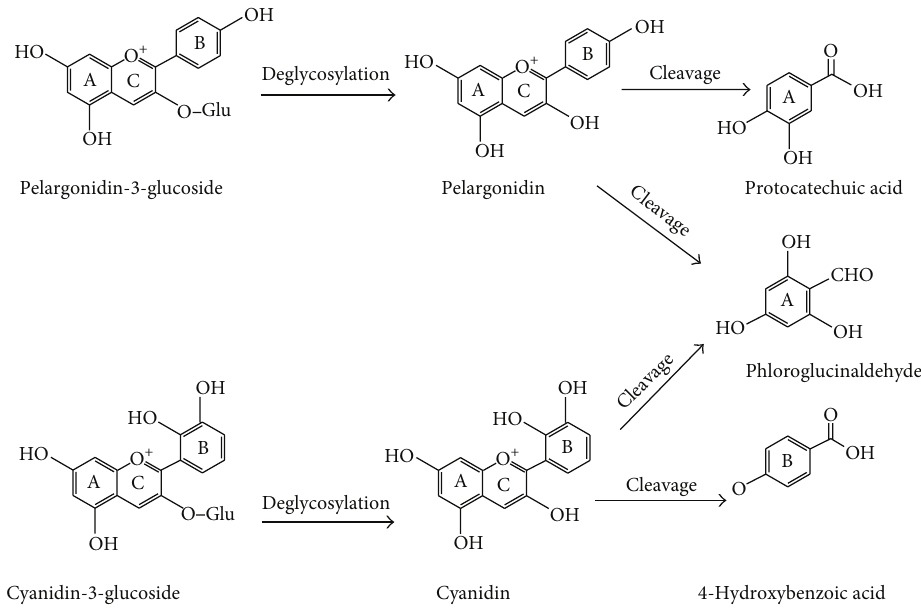
Figure 3: Thermal degradation mechanism of two common anthocyanins (adapted from